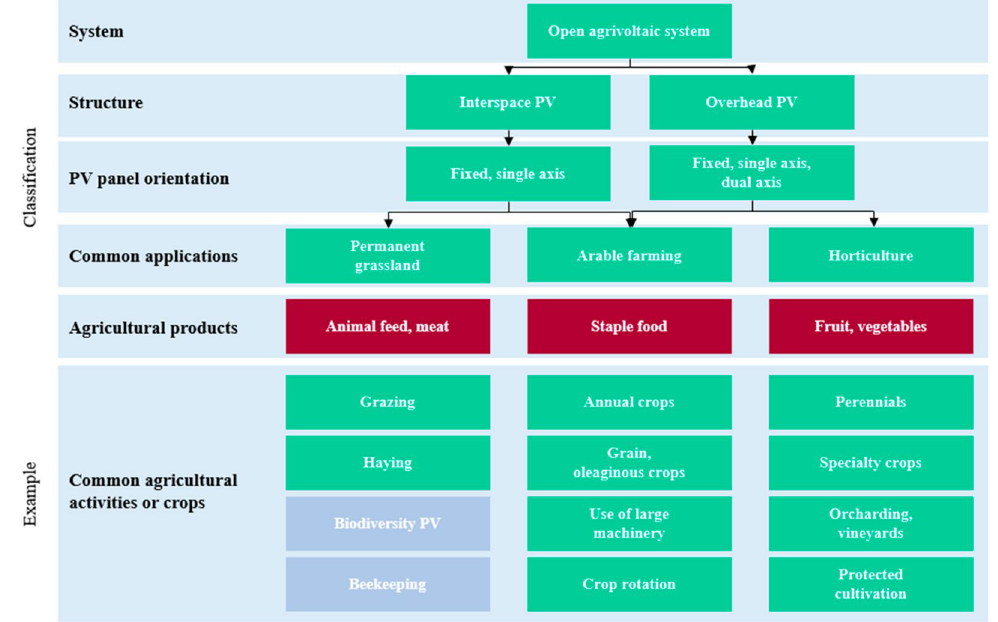
Figure 3. Summary of different agrivoltaic field systems [44,47].